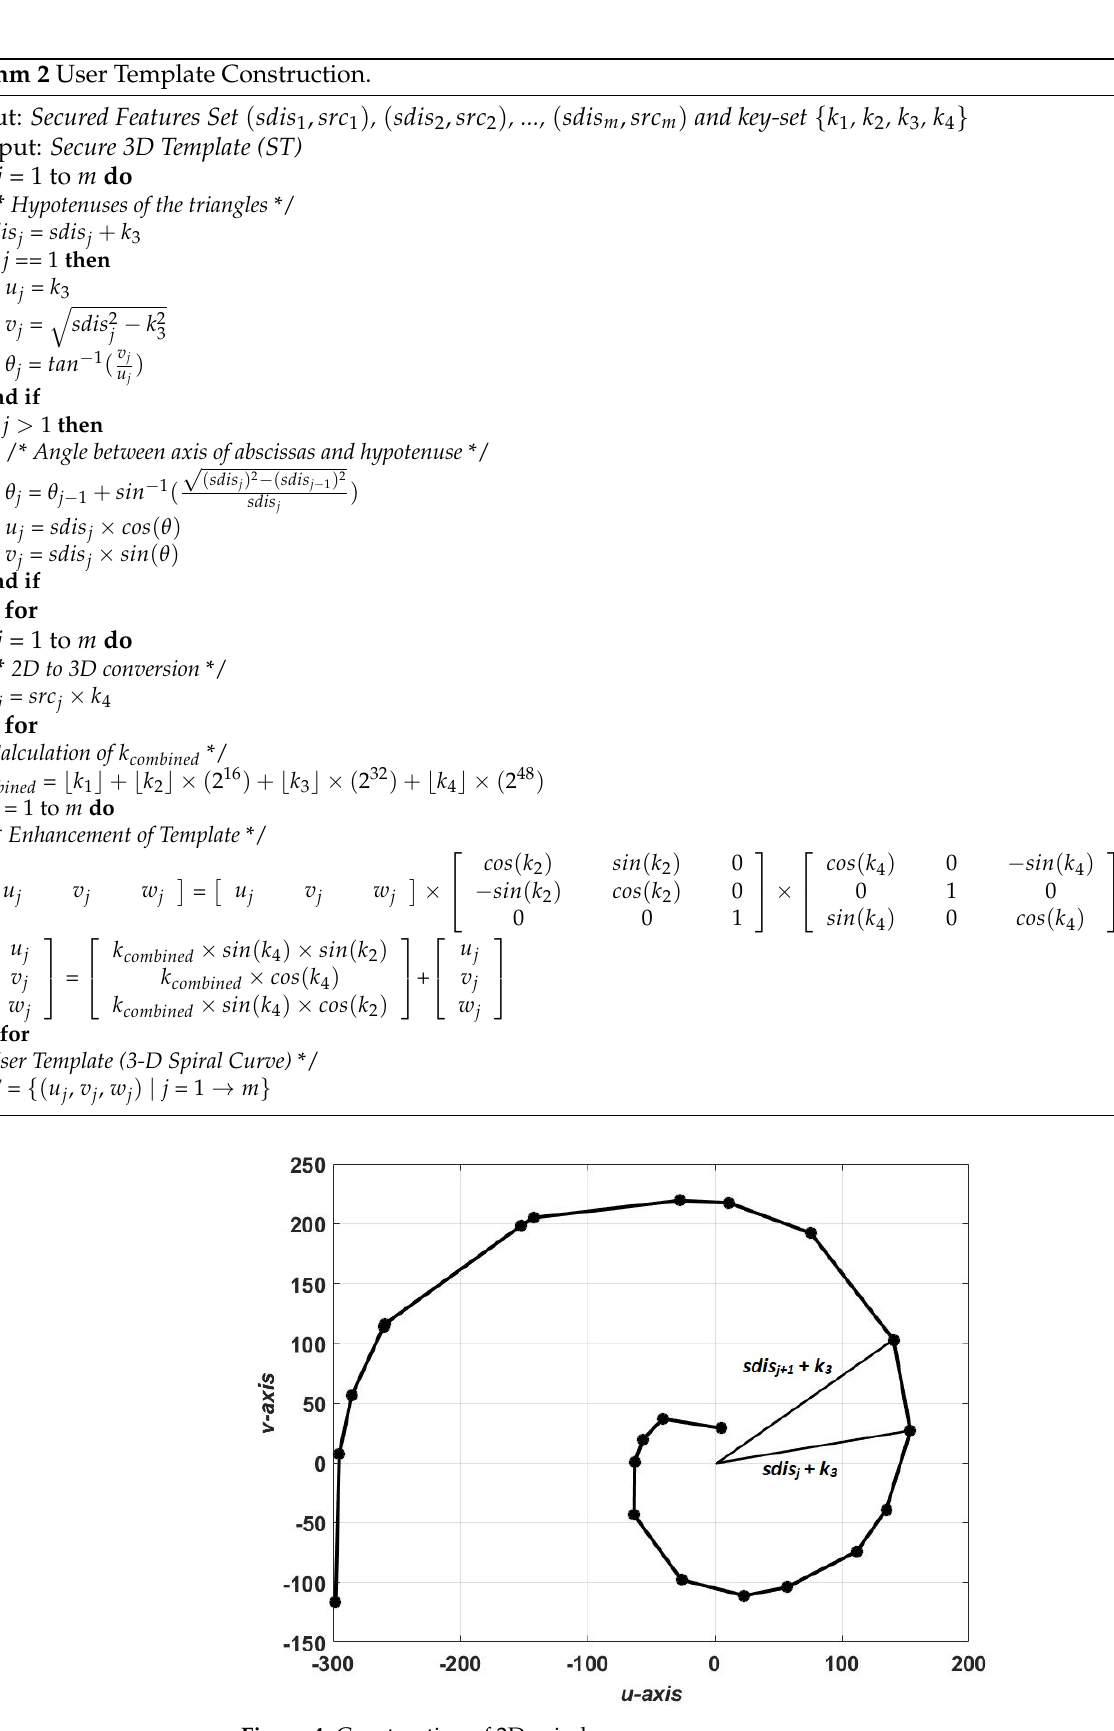
Figure 4. Construction of 2D spiral